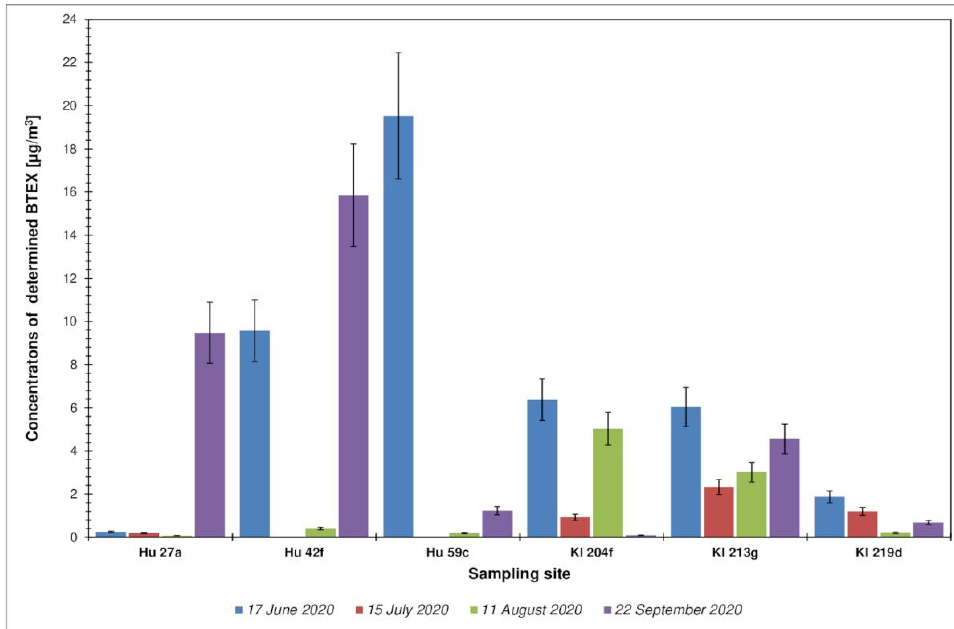
Figure 6. Total content of BTEX compounds determined for all locations and all measurement campaigns. Error bars express the standard deviation of obtained results.